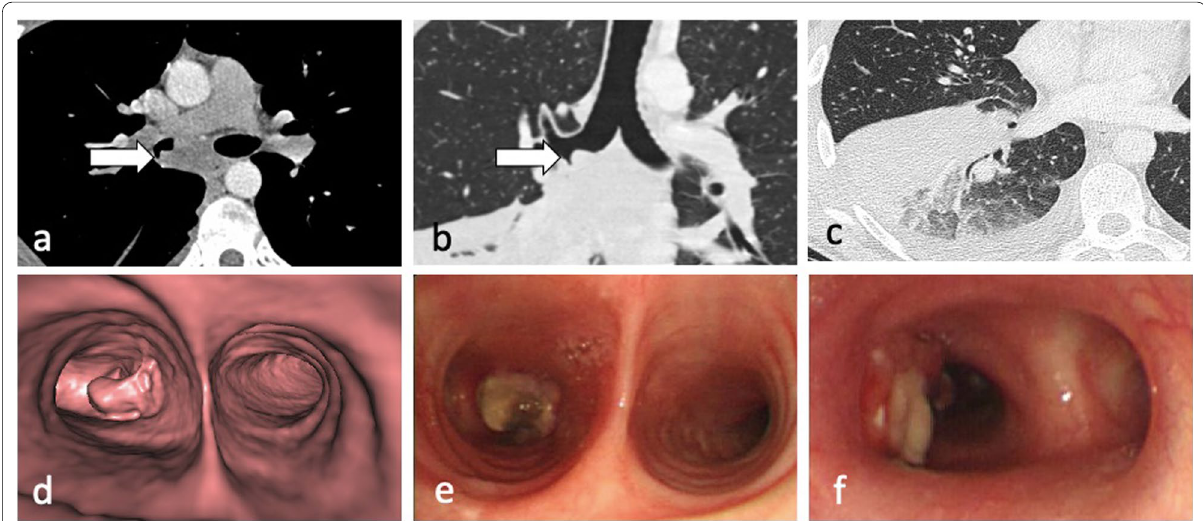
Fig. 6 A 34-year-old male with Crohn’s disease presented with recurrent pyrexia and raised inflammatory markers. CT demonstrates a 29 mm subcarinal node with central low attenuation (mediastinal window, axial plane— a , arrow) invading into the right main bronchus (lung window, coronal plane— b , arrow). There is also right lower lobe consolidation and a small right pleural effusion (lung widow, axial plane— c ). CT virtual bronchoscopy demonstrates the node protruding into the lumen of the right main bronchus ( d ) with corresponding bronchoscopy image ( e ). The